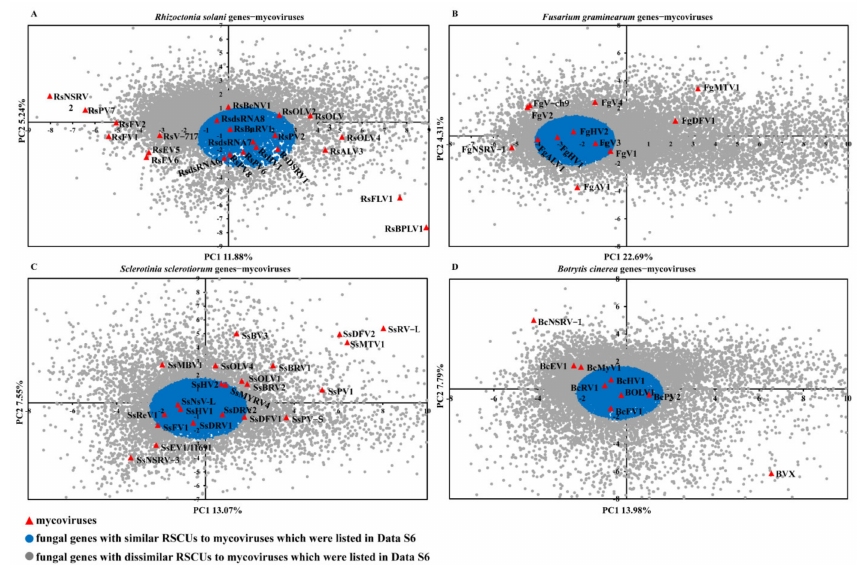
Figure 6. The PCA of the RSCUs among mycoviruses and fungal genes. The RSCU (the relative synonymous codon usage) values of fungal genes and mycoviruses were subjected to principal component analysis (PCA). The PCA was plotted by the first two axes (PC1 ( x -axis) and PC2 ( y - axis)). ( A ) R. solani genes and R. solani mycoviruses; ( B ) F. graminearum genes and F. graminearum mycoviruses; ( C ) S. sclerotiorum genes and S. sclerotiorum mycoviruses; ( D ) B. cinerea genes and B. cinerea mycoviruses. The red triangles represent the mycoviruses. The blue dots represent fungal genes that have similar RSCUs to mycoviruses, which were listed in Data S6, and the gray dots represent the other fungal